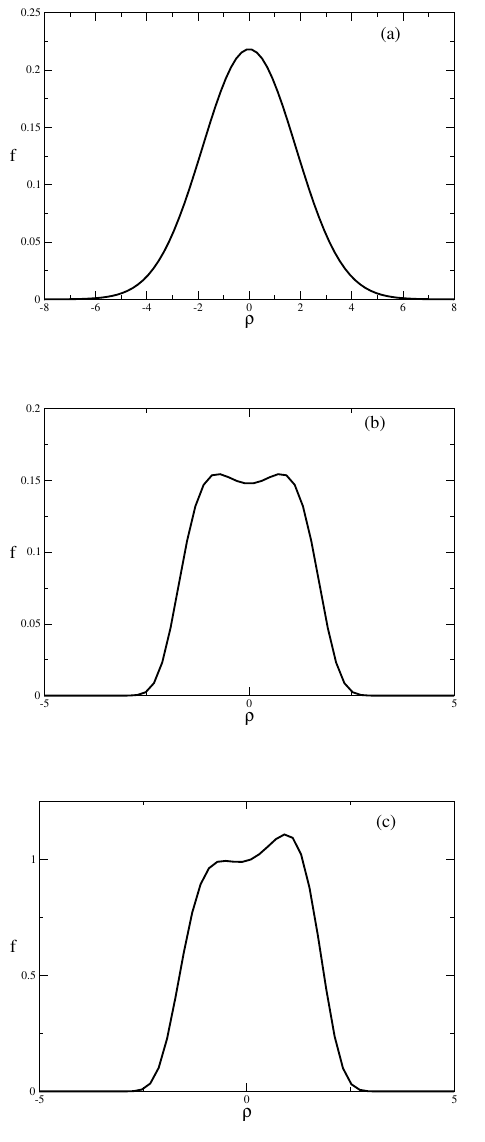
Fig. 1. Several profiles of f ( ρ ) from Eq.(33) (in the figures ρ is denoted as ρ ). Figure (a): b = 2 ; α 0 = α 2 = α 3 = 0 ; α 1 = − 0 . 3 . In this case the model equation has a single fixed point ρ = 0 and at this fixed point the maximum of the probability density function is centered. Figure (b): α 0 = α 2 = 0 ; α 1 = 0 . 3 ; α 3 = − 0 . 05 ; b = 3 . Here the fixed points are 3. The two maxima of the p.d.f. distribution are centered around the two stable fixed points and the minimum is centered on the unstable fixed point ρ = 0 . Figure (c): α 0 = 0 . 05 ; α 1 = 0 . 3 ; α 2 = 0 . 01 ; α 3 = − 0 . 05 ; b = 3 . Here the fixed points are 3 again but one of the two stable fixed points is more preferred which can be seen from the larger peak of p.d.f. function at that point.